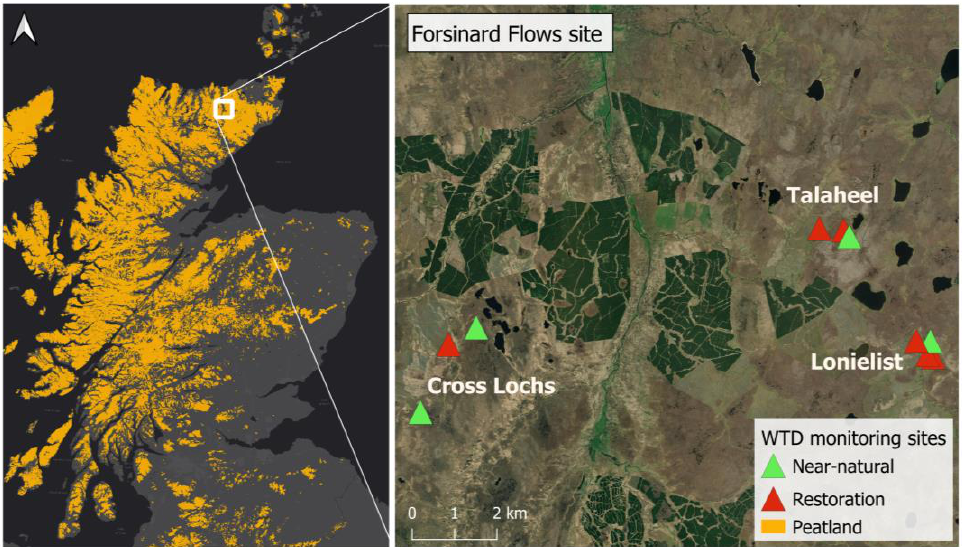
Figure 1. Peatland extent in northern Scotland [23] and the chosen study sites in the Forsinard Flows. The green triangles show the near-natural peatland study sites, and the red triangles show sites with ongoing restoration.